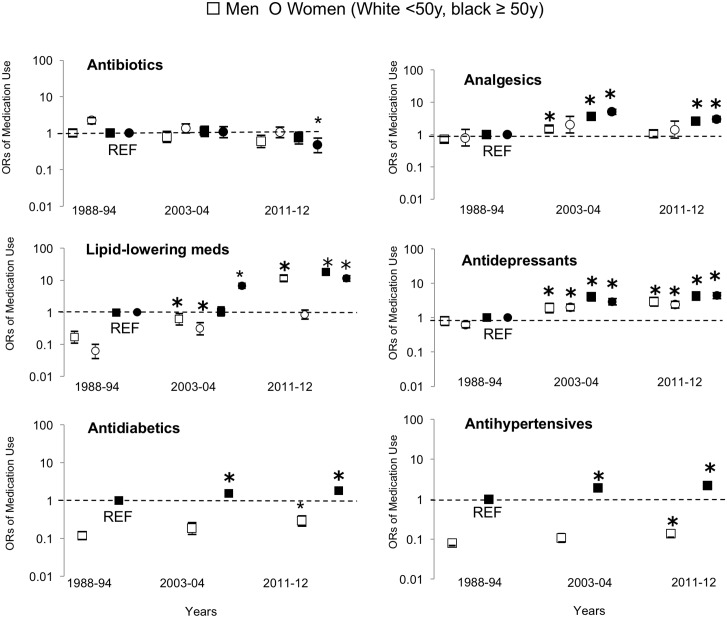
Odd ratios for prevalent medication class by age and time in men and women.The reference groups are older individuals (men and women separately) in the year 1988. For simplicity, only 3 of 7 years are shown. Models adjusted for ethnicity and education. *: Significantly different within age and sex group in 1988.